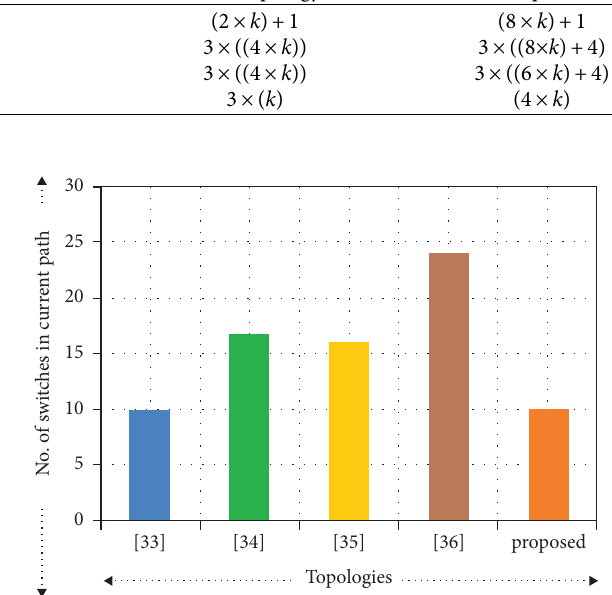
Table 2: Comparison between proposed and conventional three-phase topologies for “ k ” cells. Multilevel inverter structure